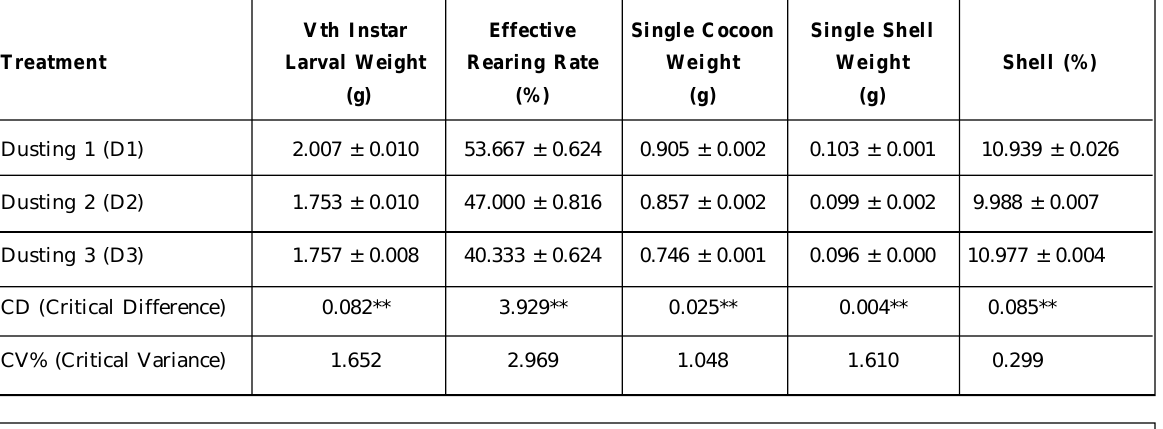
Table 3: Rearing - II: Economic parameters before challenge with Bm NPV during July- Aug, 2017-20